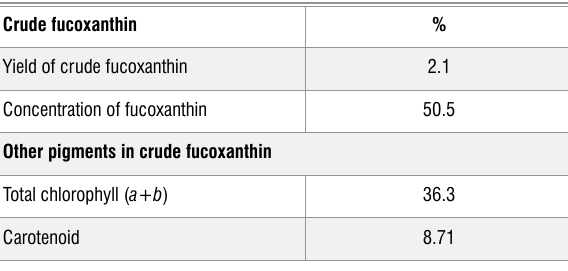
Crude fucoxanthin and other pigments from Dilophys fasciola Crude